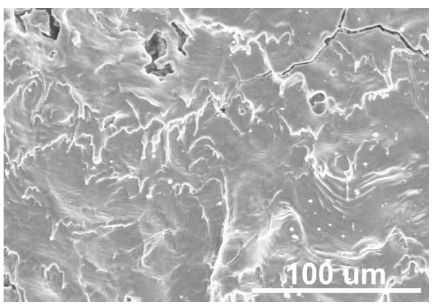
Figure 11: SEM image of sintering resulting from slowly moving the LIBS-6 beam after 10 shots.